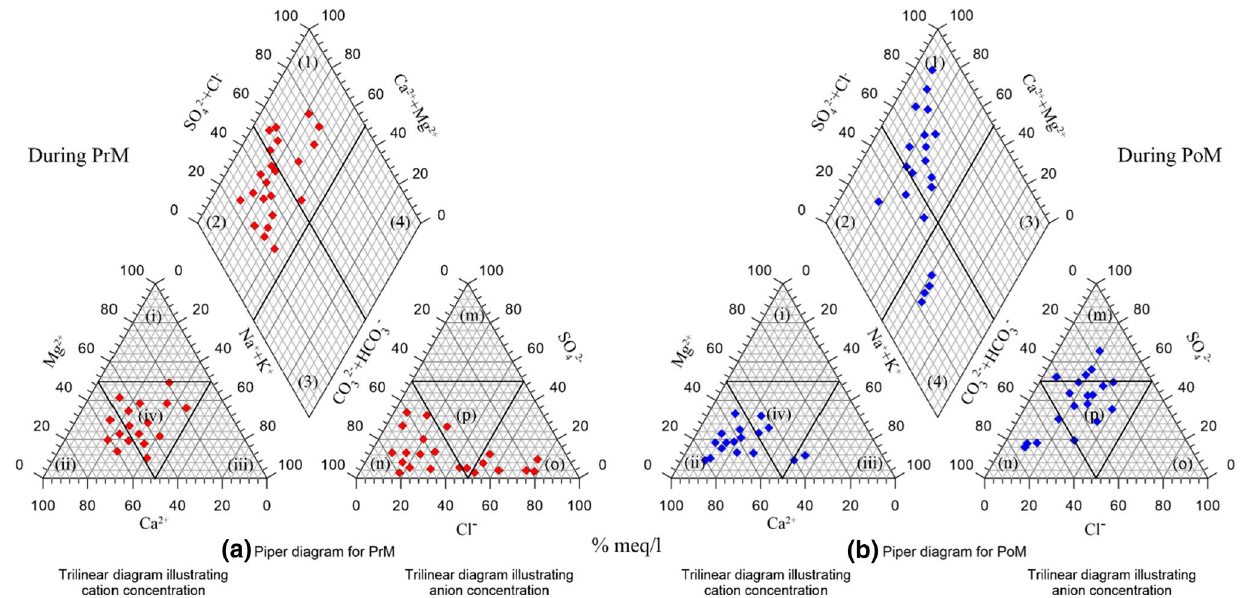
Fig. 12 Piper trilinear diagram; a PrM; b PoM. Here (1) Calcium Magnesium Sulfate Chloride; (2) Calcium Magnesium Bicarbonate; (3) Sodium Bicarbonate; (4) Sodium Chloride Sulfate; (i) Magne-